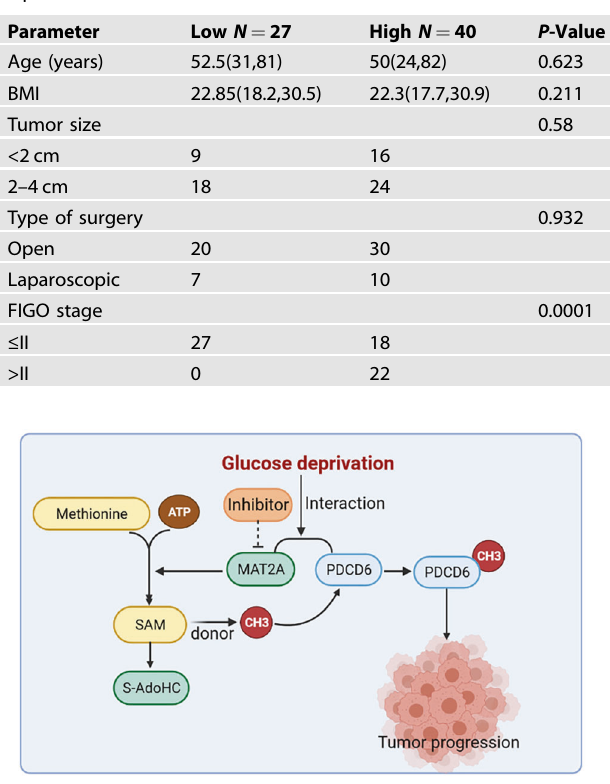
Fig. 5 MAT2A and PDCD6 are highly expressed in cervical cancer tissues and are correlated with poor prognosis with cervical cancer patients. A Immunohistochemical staining with MAT2A antibody was performed in 67 cervical cancer specimens and 67 normal cervical specimens. Representative photos of tumors versus the normal tissue and adjacent normal tissues were shown (magni fi cation: ×100 and ×400, left panel). Comparative analysis of MAT2A expression among normal cervical tissue, adjacent normal tissue and cervical cancer specimen was shown (right panel). *** P < 0.001. Scar bars: 50 μ M. B Immunohistochemical staining with PDCD6 antibody was performed in 67 cervical cancer specimens and 67 normal cervical specimens. Representative photos of tumors versus the normal tissue and adjacent normal tissue was shown (magni fi cation: ×100 and ×400, left panel). Comparative analysis of PDCD6 expression among normal cervical tissue, adjacent normal tissue and cervical cancer specimen was shown (right panel). *** P < 0.001. Scar bars: